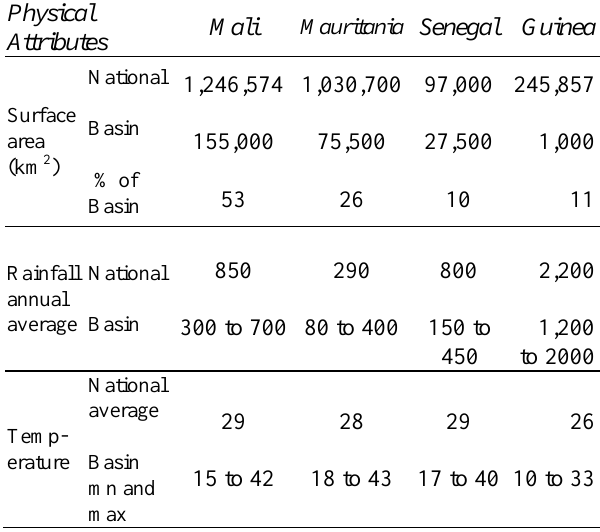
Table 2 : Summary of physical data